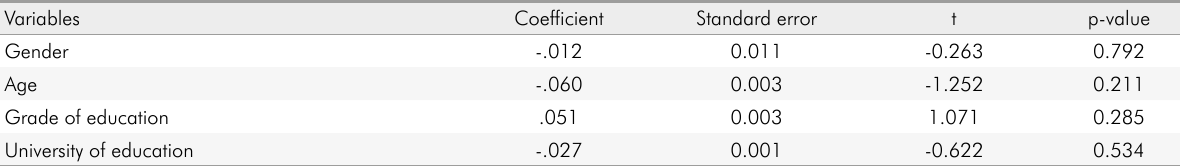
Table 3. Results of regression analysis on factors associated with COVID-19 knowledge.